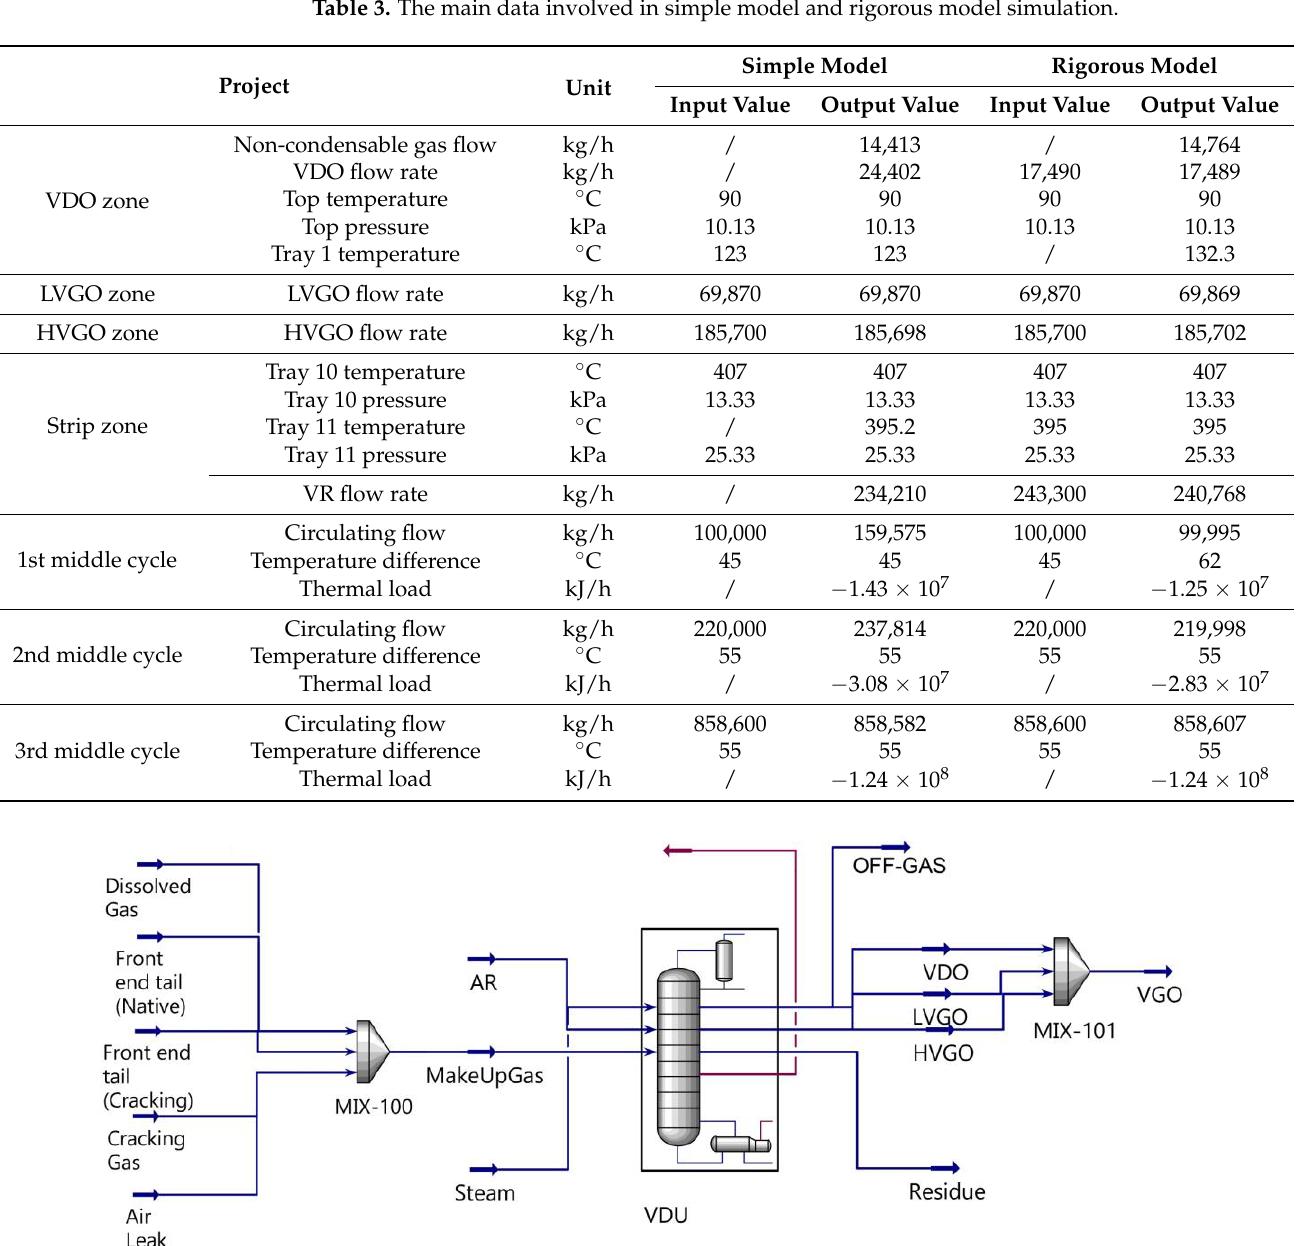
Figure 4. Process flow diagram for the rigorous model of VDU in Aspen HYSYS.